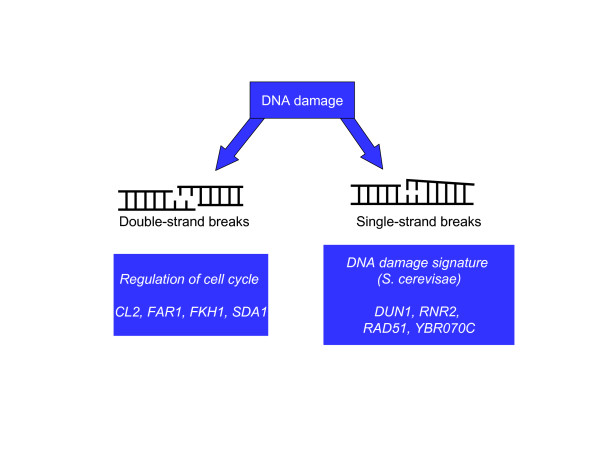
Model of specific responses in S. cerevisiae to double- or single-strand breaks.